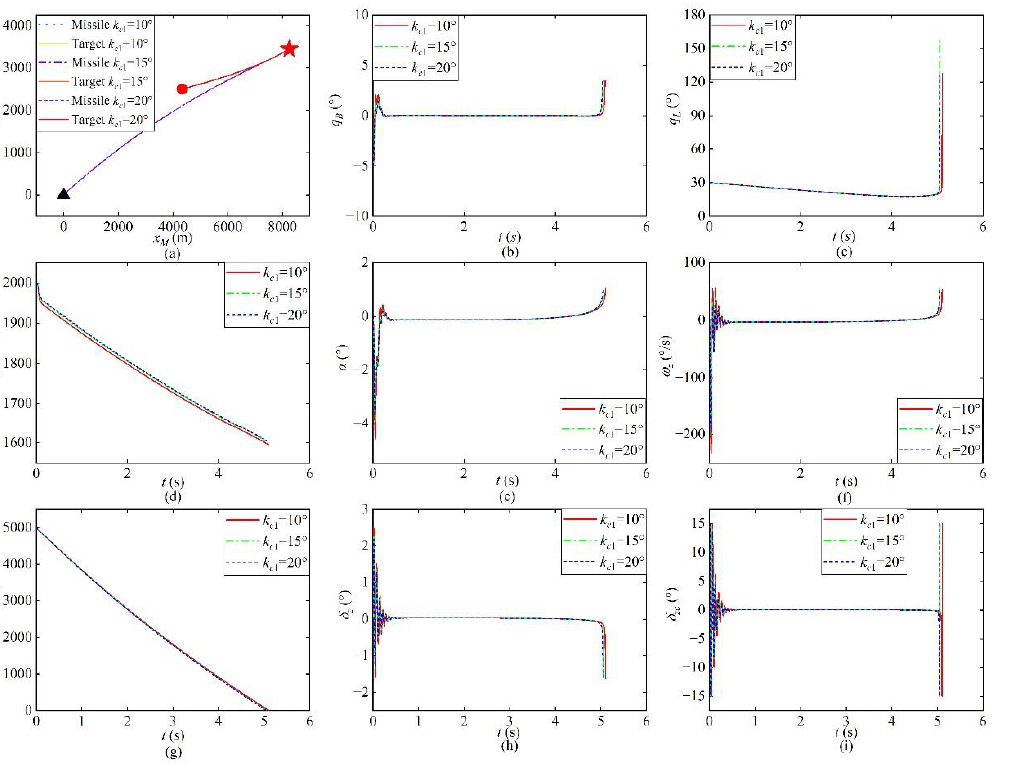
Biased Parameters